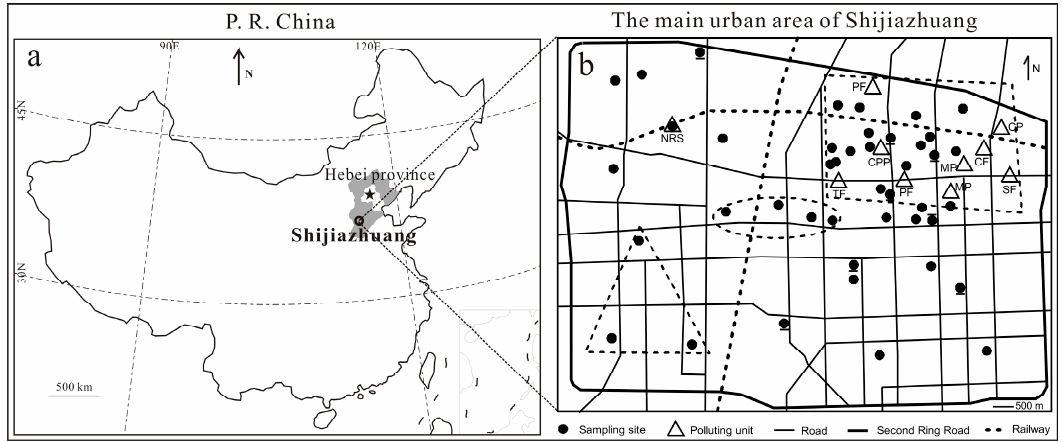
Figure 1. Location of Shijiazhuang in China ( a ) and sampling sites (solid dots) for 43 settled dust collected over the main urban area ( b ). Solid dots with short lines on the bottom or the top represent sampling sites near heavily trafficked areas. The dotted triangle, ellipse, and quadrangle in ( b ) represent the administration-education area, the commercial area, and the old industrial area, respectively. Triangles in ( b ) representative polluting units in the study area. NRS, PF, CPP, TF, MP,